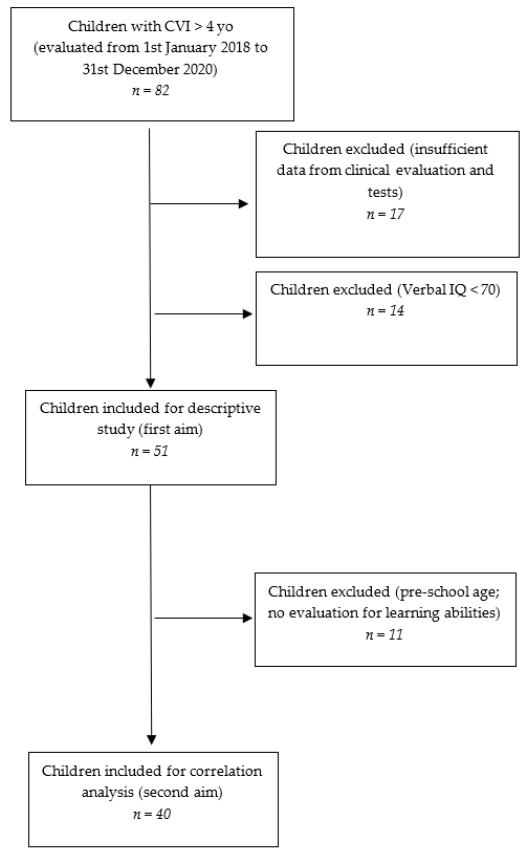
Figure 1. Flow chart of the retrospective cohort